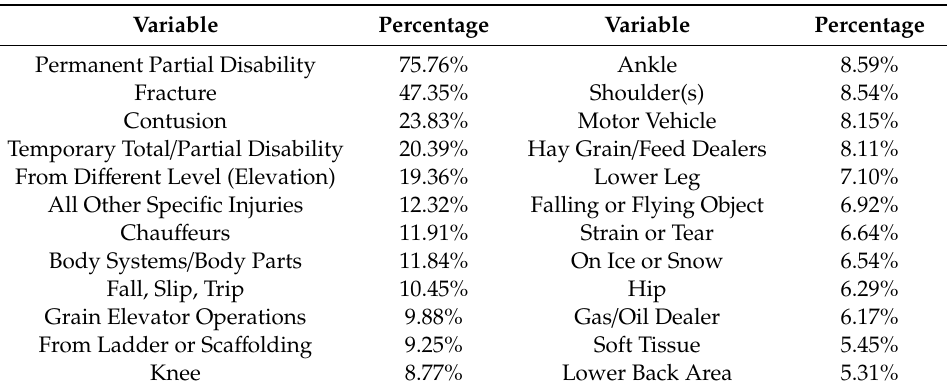
Table 6. Characteristics of injury patterns in class